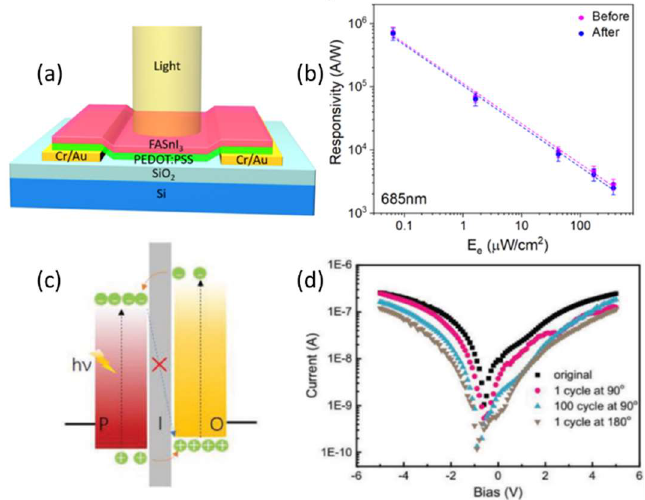
Figure 6. ( a ) Schematic diagram of the FASnI 3 /PEDOT:PSS PD, ( b ) R vs. light intensity for the flexible device before and after the bending test, reprinted with permission from [36] ©2020 ACS Publications, ( c ) schematic illustrating the energy-level diagram of the perovskite insulator organic (PIO) heterojunction and photo-induced charge generation mechanism, and ( d ) the I−V curves of the original flexible PIO device and the device subjected to 1 and 100 bending cycles at 90° and then followed by 1 cycle at 180° under the illumination of white light, reprinted with permission from [48] ©2021 Wiley.